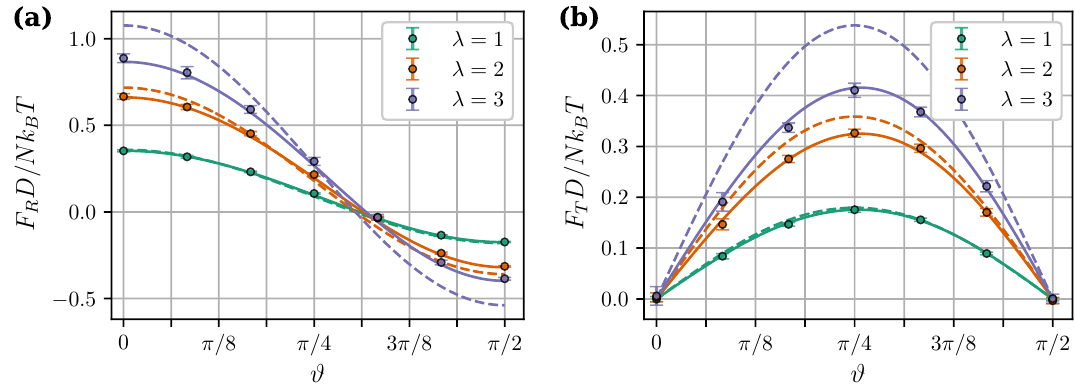
Figure 7. Central ( a ) and tangential ( b ) components of the magnetic intercluster force per core as a function of angle ϑ . ϕ = 0.3, ξ = 8, l = 1.4. Different colors correspond to different λ (see legend). Symbols are simulation results for N = 100, solid curves are from the “mutual dipoles model” (MDM) [Equations (23), (24), (29)–(32)], and dashed curves are from the “Langevin dipoles model” (LDM) [Equations (27) and (28)].